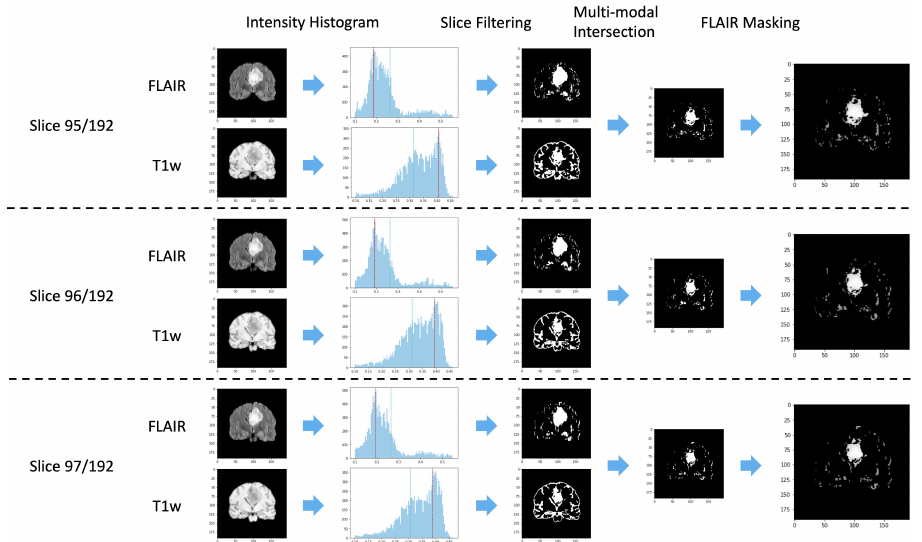
Figure 5. An illustrative example of how the KBF module operates on three consecutive couples of FLAIR and T1-W slices: the threshold based on the mode value is represented in red, while the light-blue line represents the threshold at 25% of the values for the FLAIR and T1-W